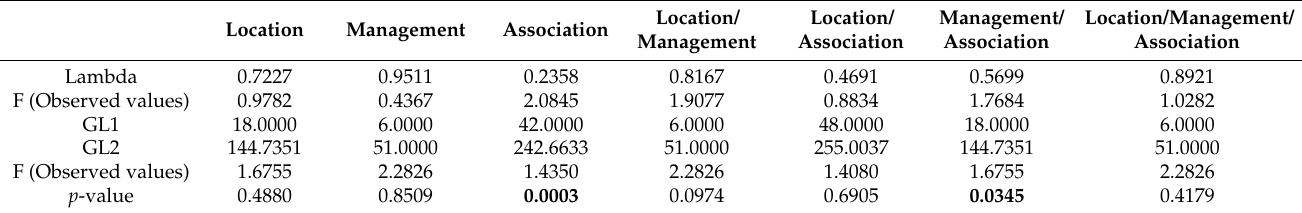
Table 3. Multivariate analysis of variance (MANOVA) showing which independent variables underwent changes: Location (tree canopy, road, fringe and dehesa ), management (herbicide, non-herbicide), type of association (BSHL, CBSM, FCSM, PRDV, UUMN, LSRR or RACC) or a combination of these can influence the dependent variables (biodiversity indices in this case). In bold, significant values at 95% confidence.